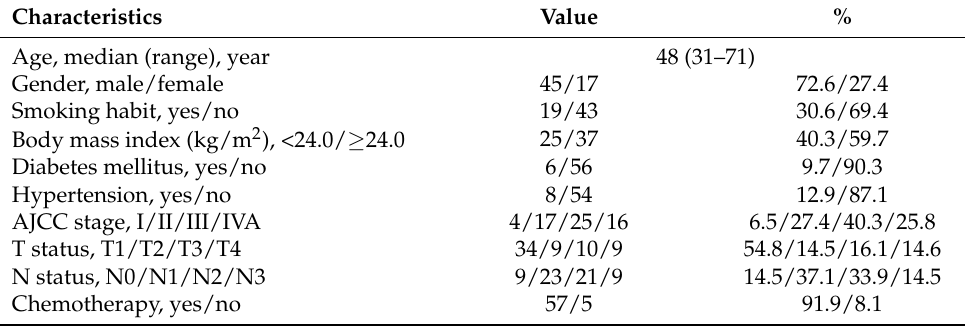
Table 1. Patient characteristics (N =